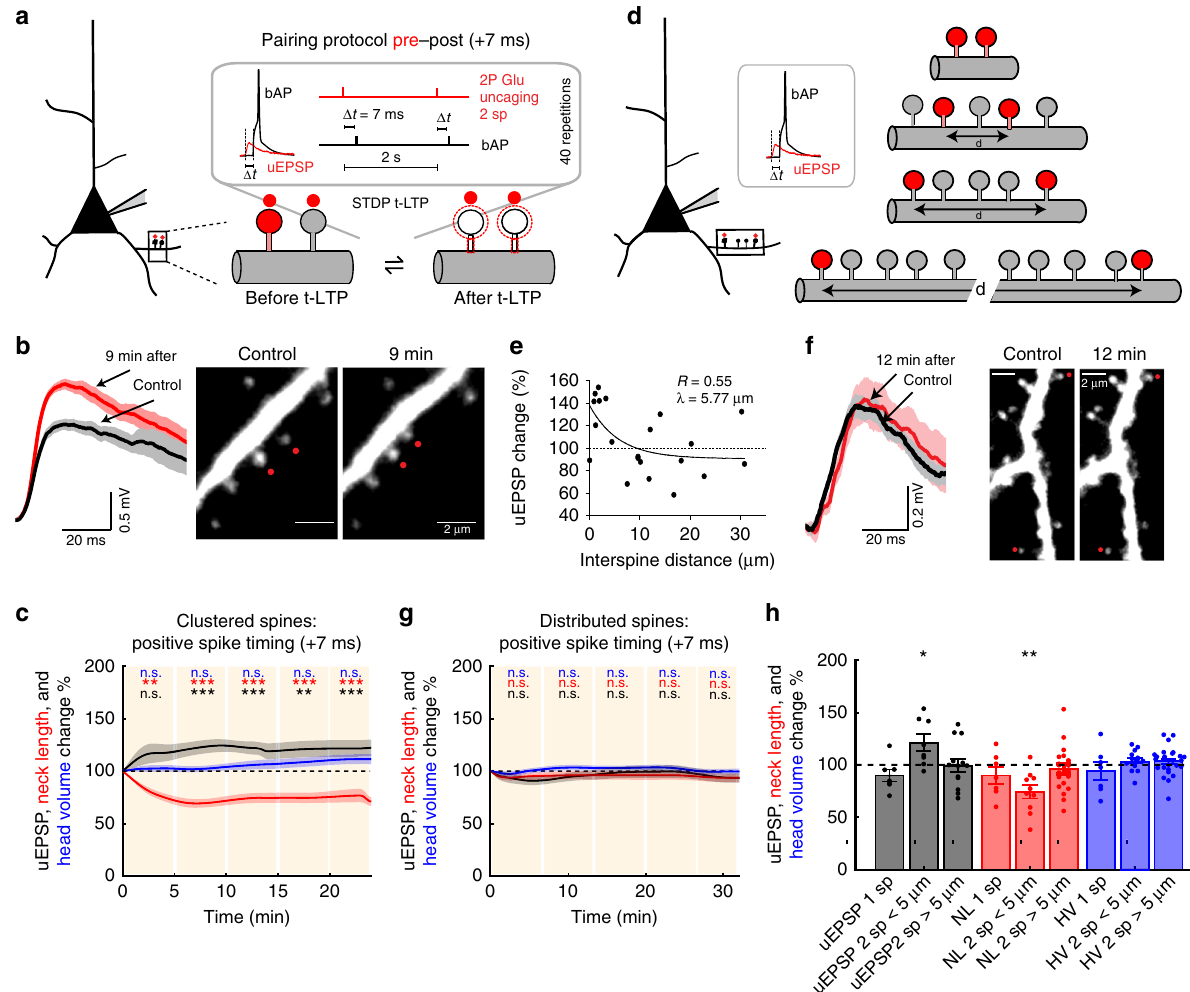
Fig. 3 Induction of t-LTP in clustered and distributed dendritic spines. a Experimental protocol for t-LTP induction in two clustered dendritic spines (<5 µ m apart). b Representative experiment for t-LTP induction (pre – post pairing of + 7 ms) in two clustered spines. Traces correspond to the average of 10 uEPSPs recorded in the soma and generated by 2P uncaging before (control, black trace) and after t-LTP induction (red trace) over indicated spines (red dots). c Time course of uEPSP amplitude, neck length, and spine head volume ( P < 0.001, P < 0.001, P = 0.47, respectively, n = 8 spine pairs, one-way repeated-measures ANOVA) changes following STDP induction ( + 7 ms) in two clustered spines. n.s. not signi fi cant; ** P < 0.01, ***P < 0.001, post hoc Dunnet ’ s test. d Experimental protocol for t-LTP induction ( + 7 ms) in two distributed spines (>5 μ m apart). e t-LTP induction ( + 7 ms) in two nearly simultaneously activated spines is dependent on interspine distance. The estimated value of λ represents the boundary between clustered and distributed spines. f Same as b , but for two distributed spines (>5 μ m apart). g Time course of uEPSP amplitude, neck length and spine head volume ( P = 0.45, 0.07, and 0.64, respectively, one-way repeated-measures ANOVA) following STDP induction ( + 7 ms) in two distributed spines. n.s. not signi fi cant, post hoc Dunnet ’ s test. h Changes in uEPSP amplitude, neck length, and head volume for individual (1 sp), clustered (<5 μ m) and distributed (>5 μ m) spines (2 sp) 15 – 25 min after t-LTP induction ( + 7 ms) (clustered: uEPSP = 121.73 ± 7.92%, P = 0.02, n = 8 spine pairs; neck length = 74.33 ± 6.35%, P = 0.0039; spine head volume = 107.92 ± 3.69%, P = 0.039; distributed: uEPSP = 100.03 ± 6.18%, P = 0.95, n = 12 spine pairs; neck length = 95.88 ± 4.87%, P = 0.28; spine head volume = 103.71 ± 2.61%, P = 0.11, two-sided Wilcoxon test; * P < 0.05, ** P < 0.01). Shaded area and error bars represent SEM. Lines, bars, and dots in c , g , h : uEPSP = black, neck length (NL) = red, and head volume (HV) =